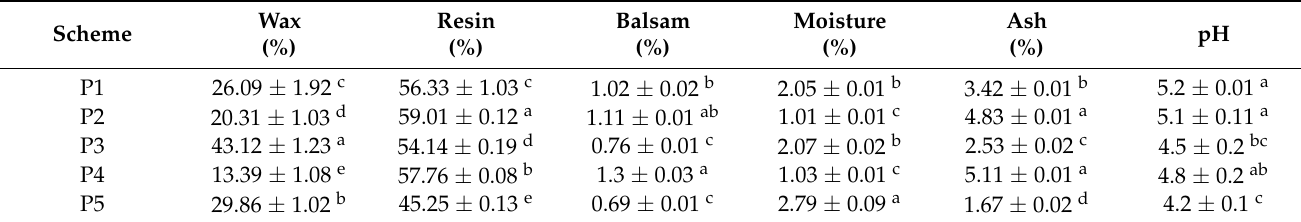
Table 1. Moisture, ash, pH, wax, balsam, and resin contents of propolis